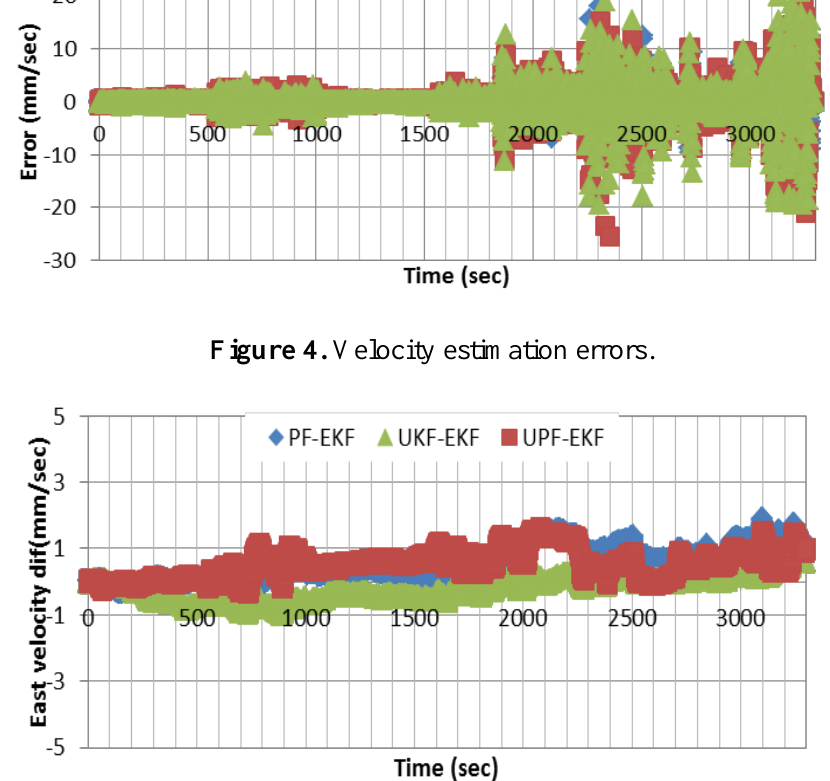
Figure 5. Difference between UKF, PF, and UPF east velocity estimation results and the altitude estimated using